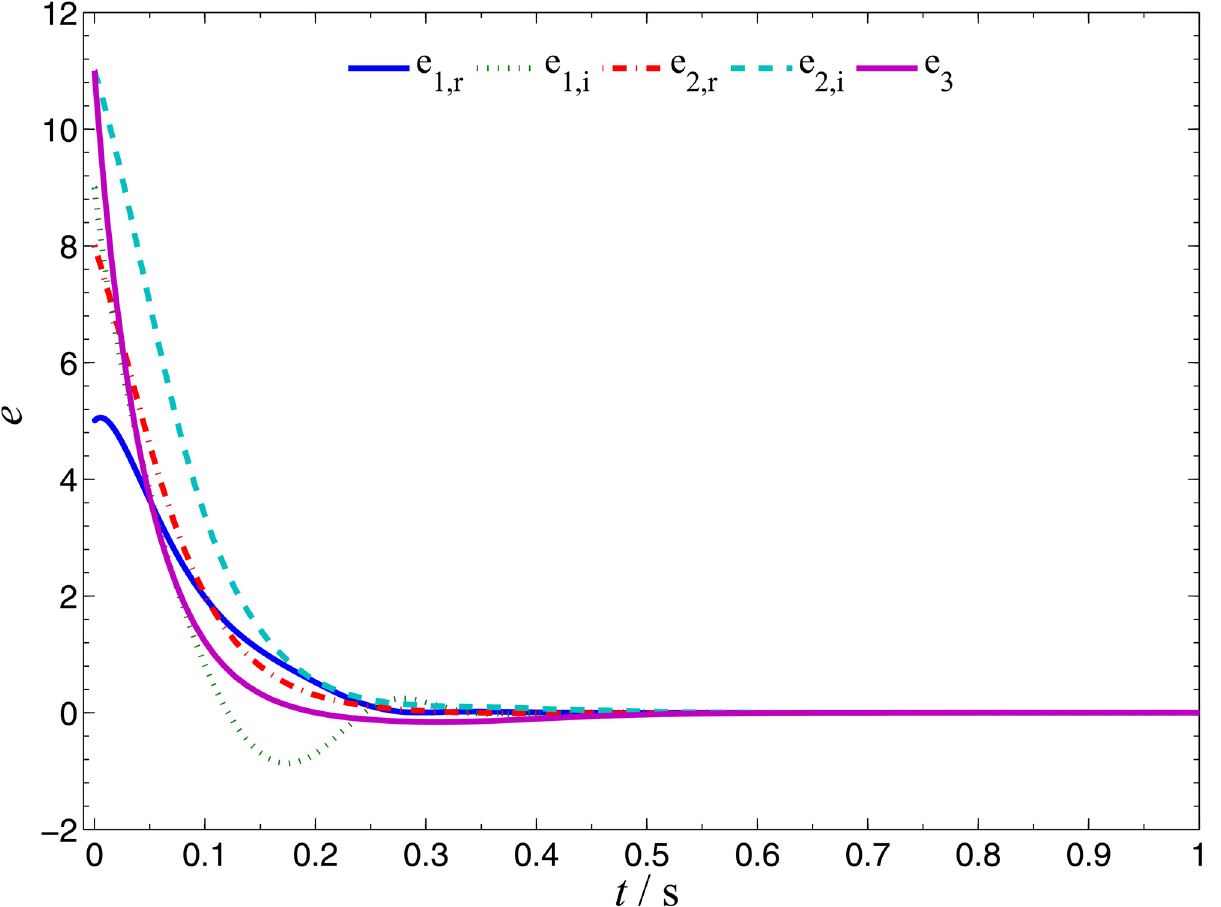
Fig 12. CGS errors of systems (12) and